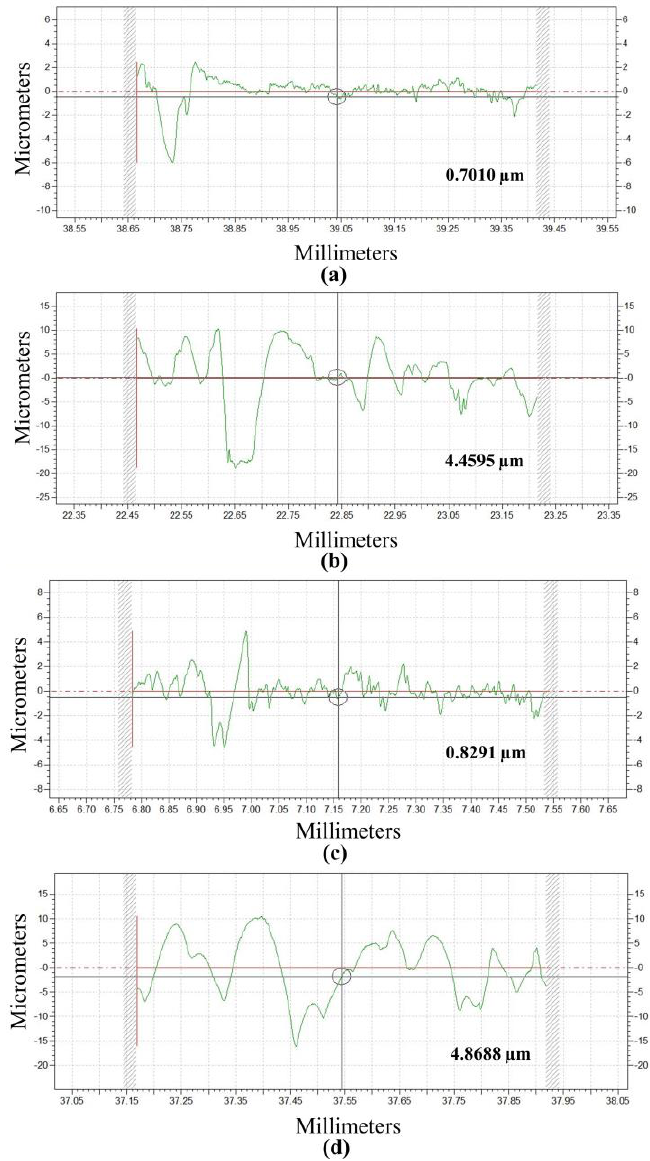
Figure 4. Roughness profiles: MoS 2 -CEC ( a ) A = 5500 rpm, B = 0.03 mm.rev −1 , C = 8 mm, D = 4 wt%; ( b ) A = 1000 rpm, B = 0.07 mm.rev −1 , C = 4 mm, D = 8 wt%; BN-CEC ( c ) A = 5500 rpm, B = 0.03 mm.rev −1 , C = 8 mm, D = 4 wt% and ( d ) A = 1000 rpm, B = 0.07 mm.rev −1 , C = 4 mm, D = 8 wt%.